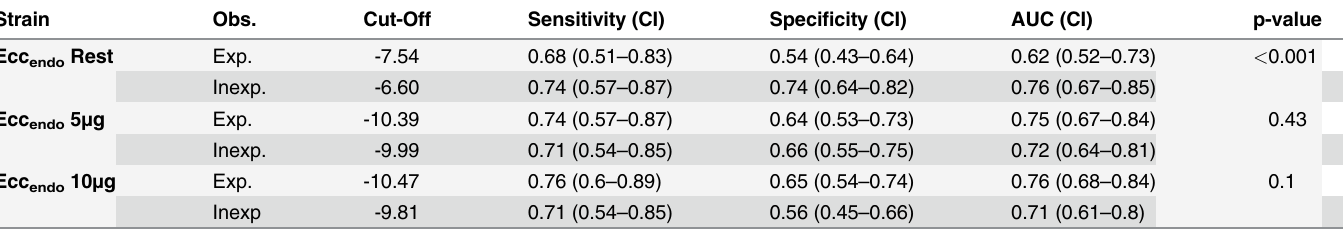
Table 3. The table shows the individual thresholds (cut-off) for left ventricular short-axis subendocardial circumferential strain (Ecc endo ) as as- sessed by one experienced (Exp.) and one inexperienced (Inexp.) observer (Obs.) at rest and with 5 and 10 μ g of dobutamine. Strain Obs. Cut-Off